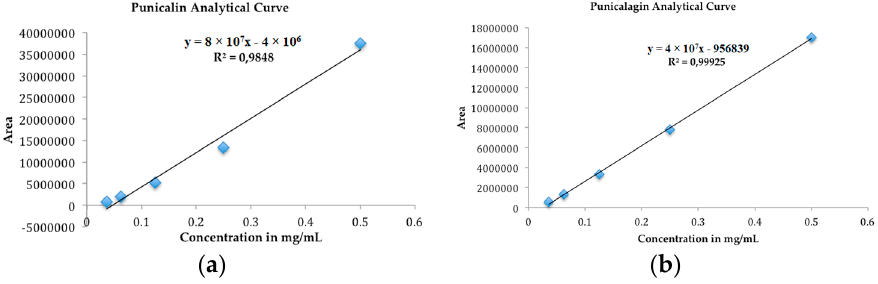
Figure 3. Analytical curves of the biomarkers ( a ) punicalin and ( b ) punicalagin.